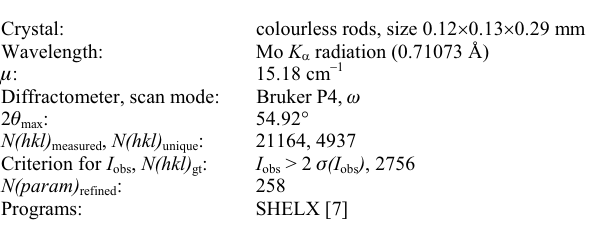
Table 1. Data collection and handling.